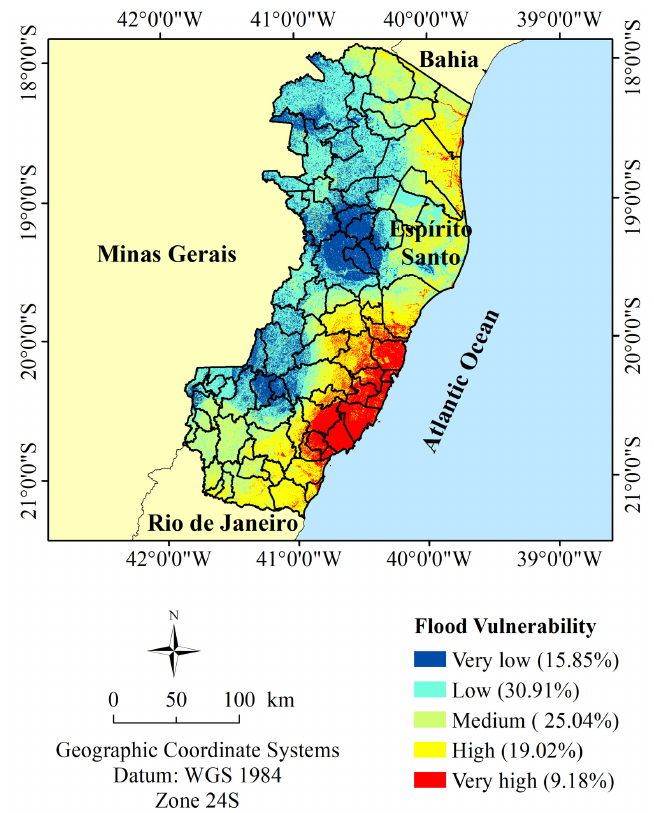
Figure 7. Dry period flood vulnerability for Espírito Santo